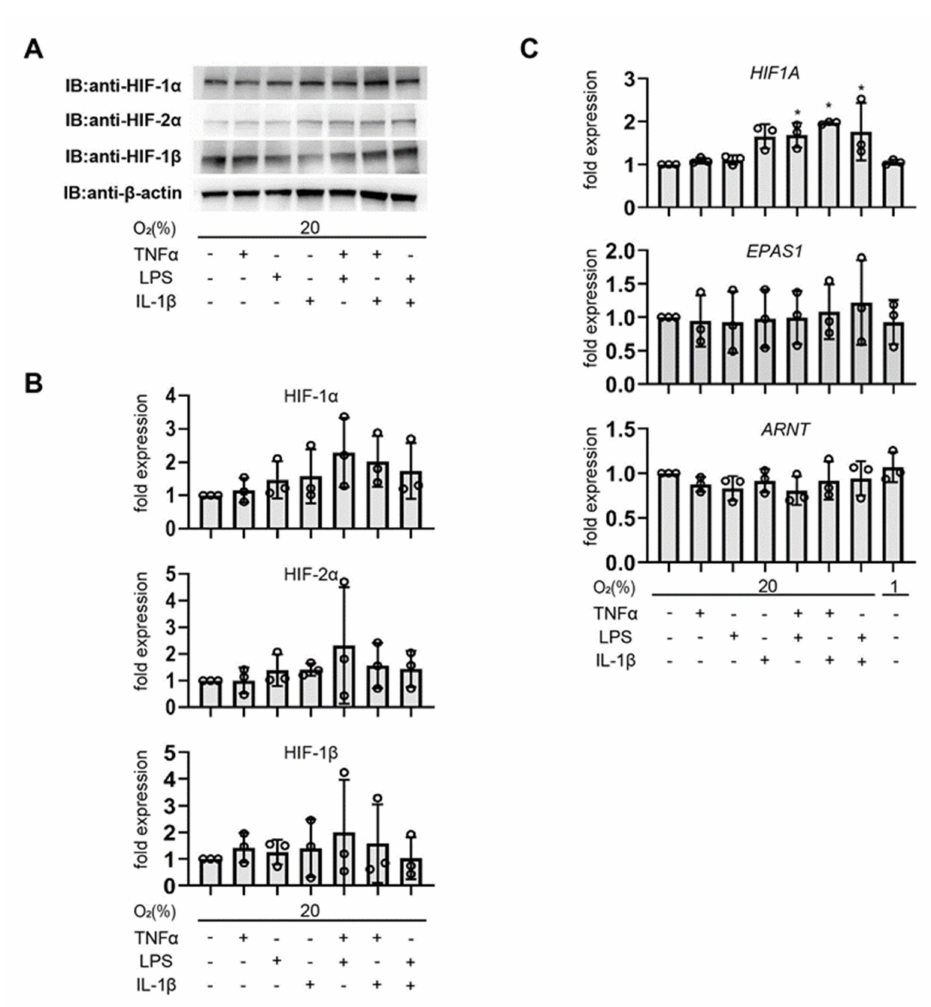
Figure 1. Under non-hypoxic situations, pro-inflammatory substances tend to cause the buildup of HIF-1 protein in endometrial epithelial cells. Immortalized endometrial epithelial cells EM- E6/E7/TERT were incubated with culture media (-), TNF α (500 ng/mL), IL-1 β (100 ng/mL), and LPS (500 ng/mL) under 20% O 2 conditions for 6 h before protein and total RNA were extracted. ( A ) Illustrations of immunoblots. Immunoblotting was performed on whole-cell lysates for HIF-1 α , HIF-2 α , HIF-1 β , and β -actin. There were at least three such experiments carried out. ( B ) Densitomet- ric analysis results that have been β -actin-normalized. ( C ) After normalizing the results to the total RNA levels of EF-1 α , semi-quantitative RT-PCR was used to examine the total RNA for the presence of HIF1A , EPAS1 , and ARNT . Data are presented as the mean ( n = 3) and standard deviation (SD). * p < 0.05 in comparison to the control group (20% O 2 circumstances without cytokine